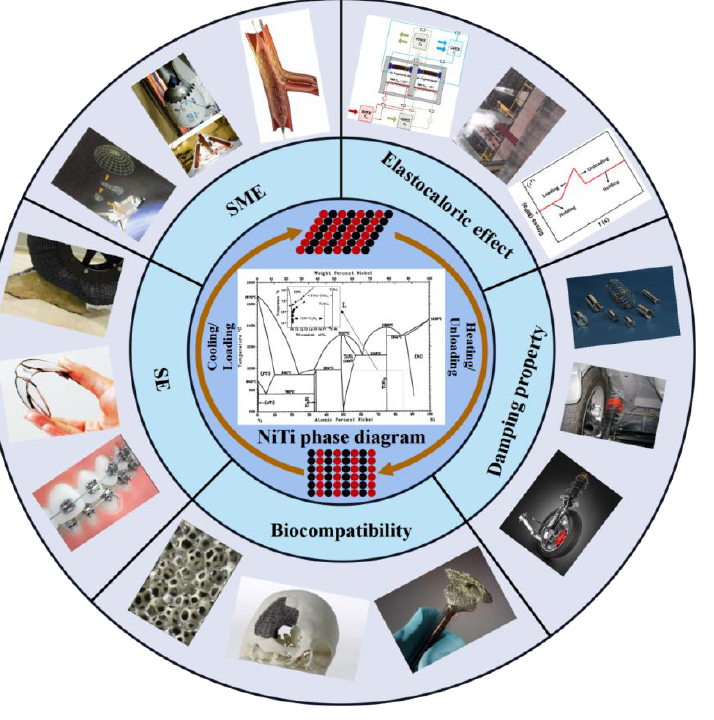
Figure 1. Properties and applications of Ni-Ti SMAs.